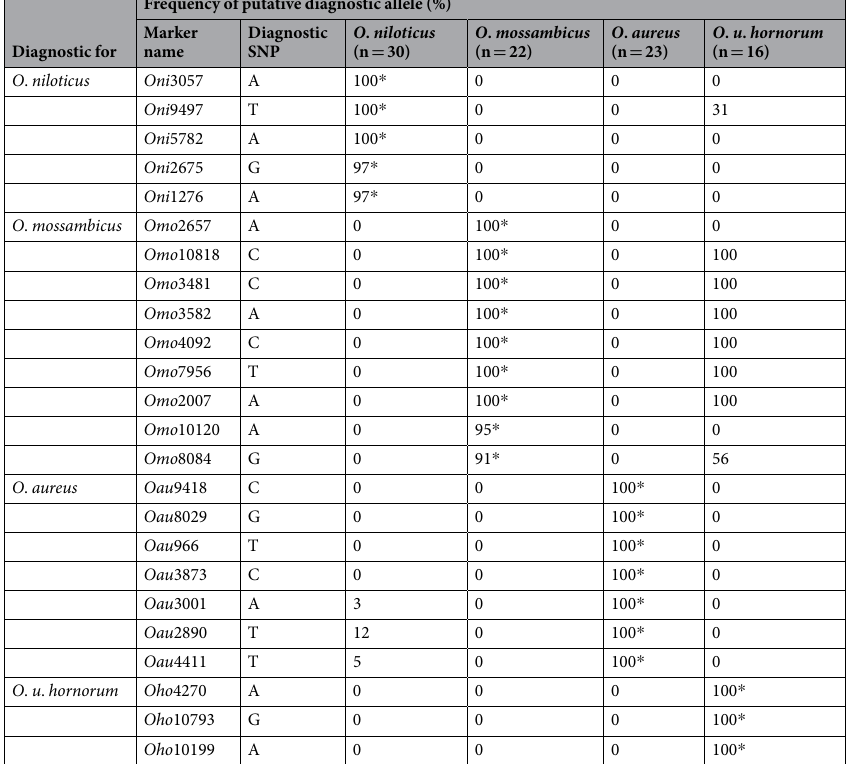
Table 3. Summary of diagnostic allele frequency for 24 putative diagnostic markers identified by ddRAD and tested by KASP genotyping assays in 91 individuals to distinguish among O . niloticus , O . mossambicus , O . aureus and O . u . hornorum . Refer to Supplementary Table S3 for full genotype data. * Frequencies of the putative diagnostic alleles in the target